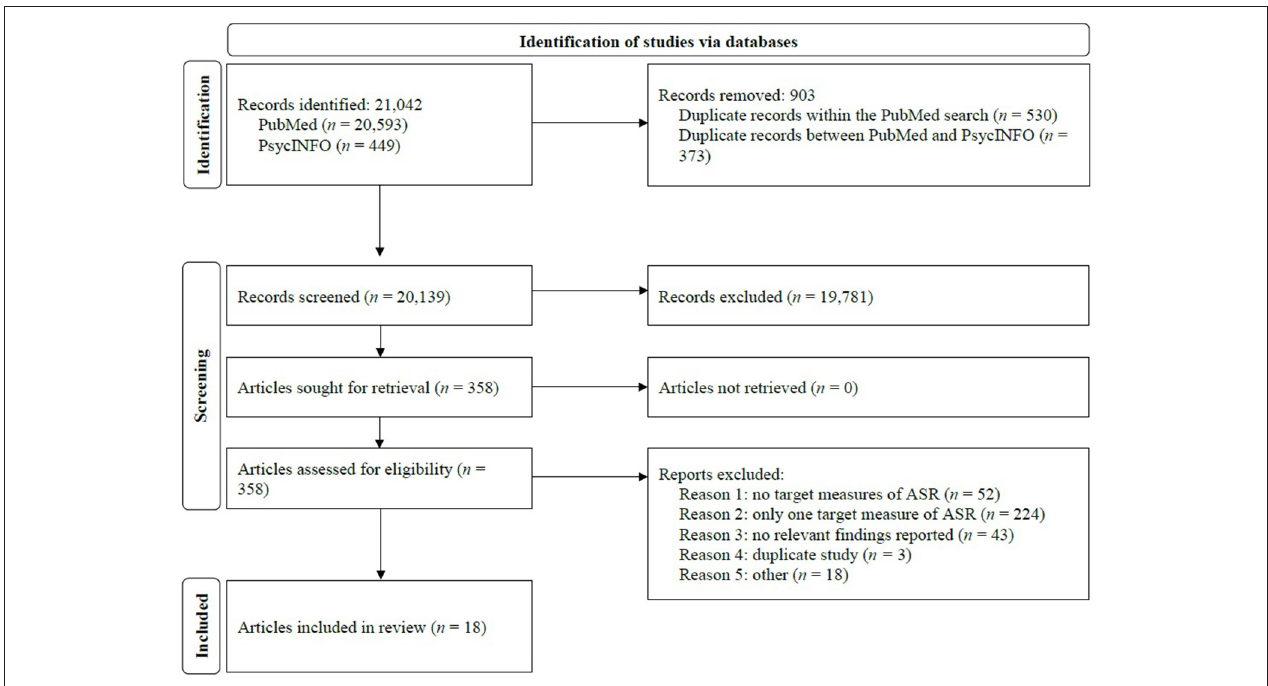
FIGURE 1 | Flow chart of the identification, selection, and inclusion of the retrieved